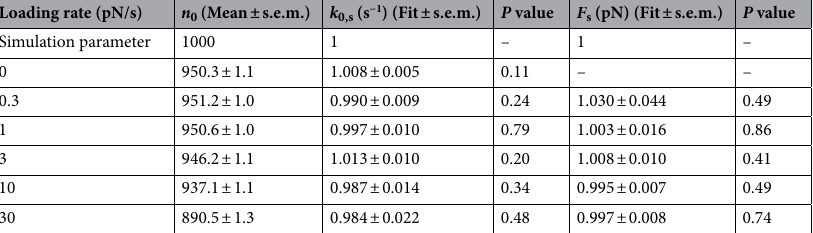
Table 2. Mean fit parameters from simulated slip bond dissociation data sets where short events have been removed. Reported values represent the mean ± s.e.m. of the fit parameters for the same 50 sets of simulated slip bond dissociation data as in Table 1, but where short events corresponding to those that are indistinguishable from experimental noise have been removed. In all cases, P values are calculated for two- tailed t-tests.